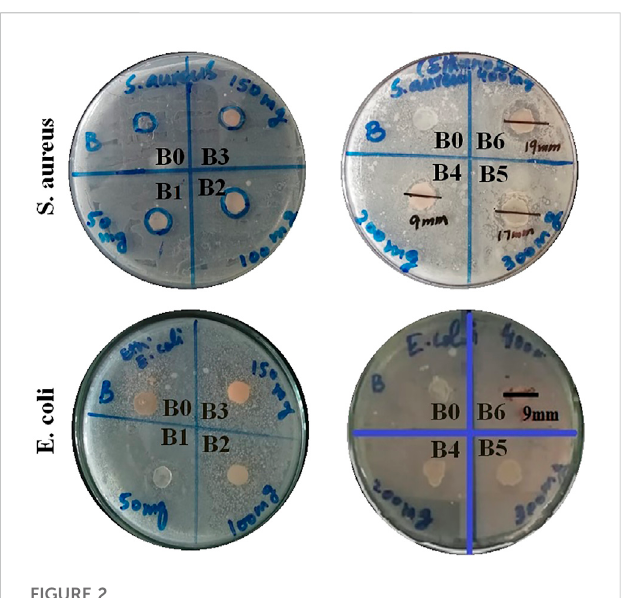
FIGURE 2 Antibacterial activity at different extract concentration-loaded hydrogel fi lms against S. aureus and E. coli